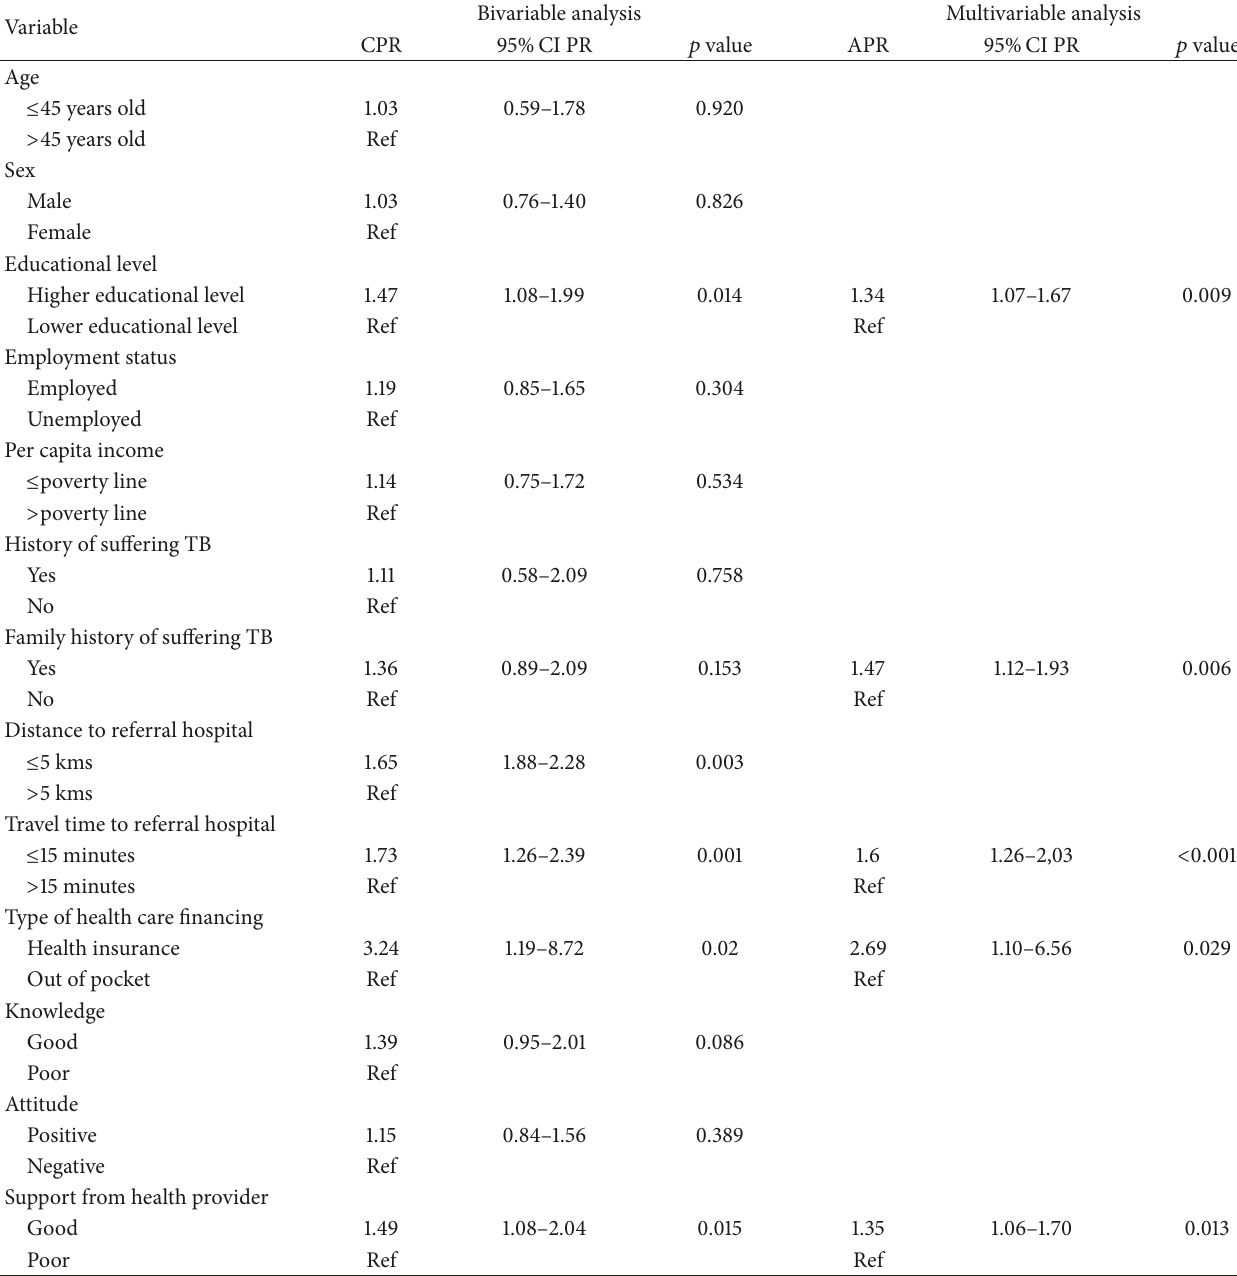
Table 3: Analysis of factors influencing participation in pulmonary TB screening among DM type II patients, Denpasar, January–March